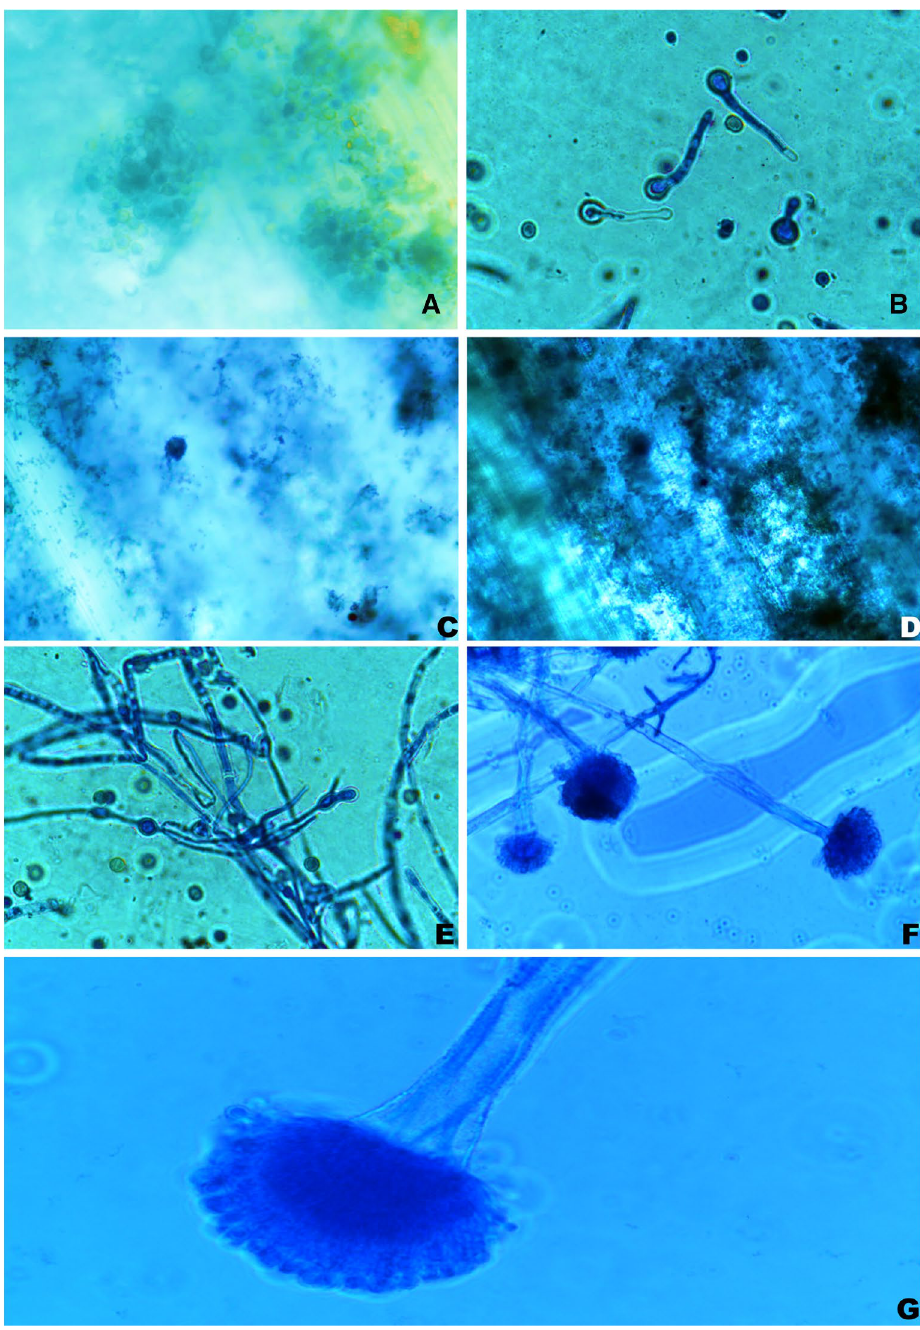
Figure 10. Development of A. niger in rice straw after inoculation ( A —Spores accumulated after inoculation, B — A. niger spore germination, C —Development of mycelia in rice straw, D —Thick growth has been seen in the 3rd day after inoculation, E —Mycelial growth of A. niger on 5th day after inoculation, F — 100× magnification of conidiophore along with fungal mycelium, G —100× magnification of fruiting body of A. niger